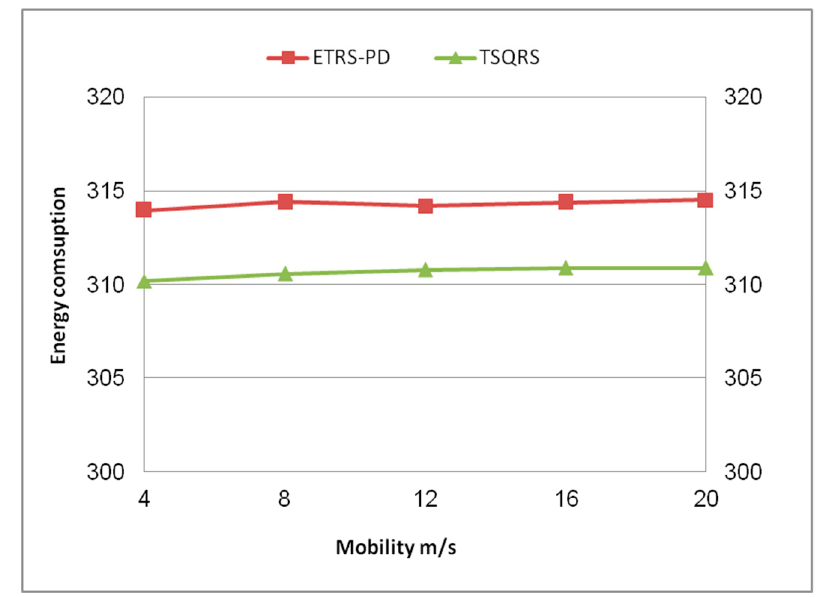
Figure 7. Energy consumption (EC) against mobility.